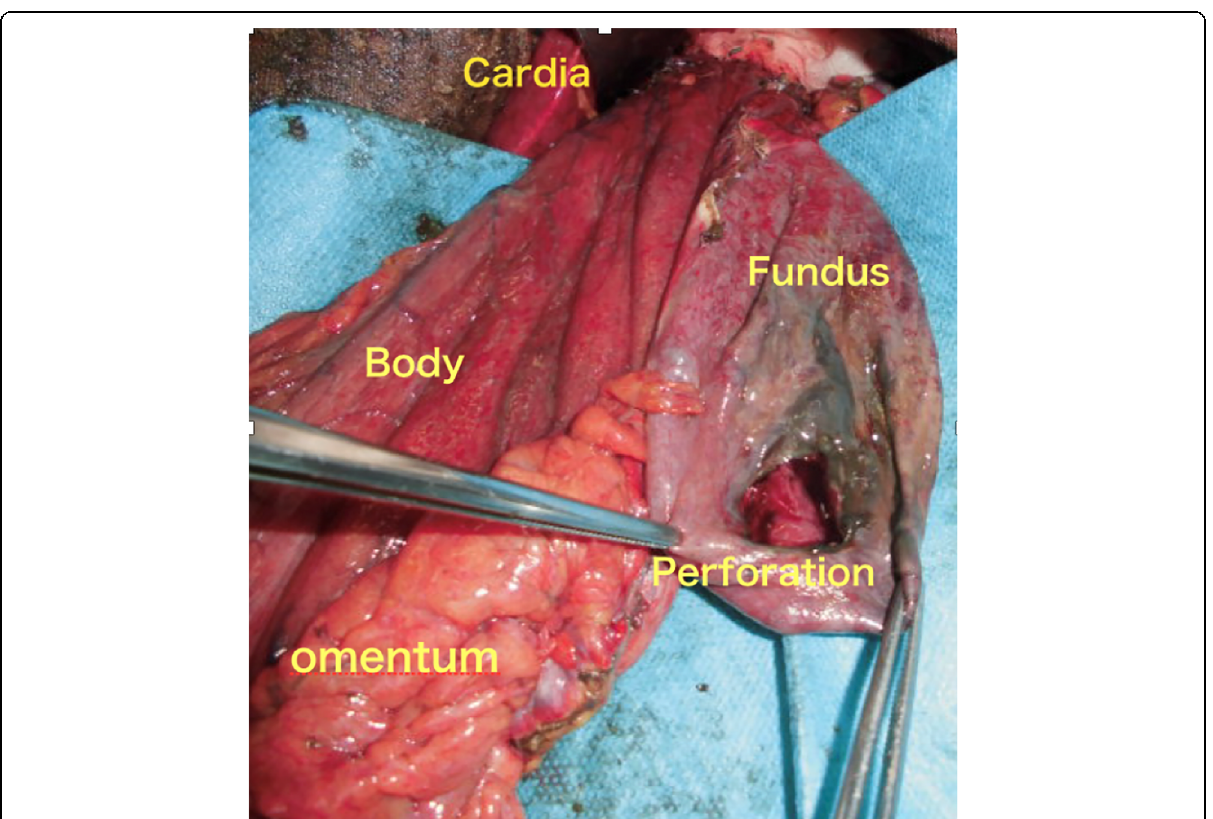
Fig. 2 Operative findings and schema. Most of the gastric body and half of the fundus were incarcerated. The antrum and part of the fundus were outside of the hernia sac. After stomach reduction, a 7-cm perforation was seen on the posterior wall of the gastric fundus